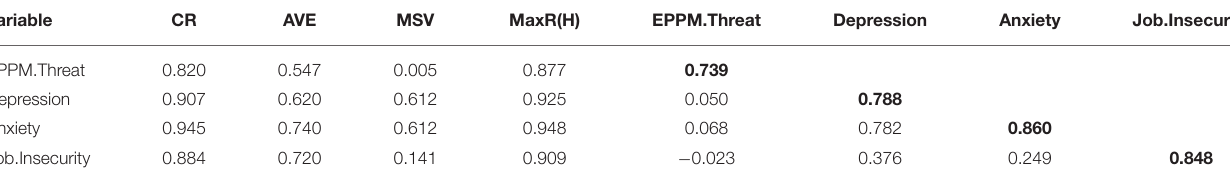
The bold values represent square root of the AVE for each of the